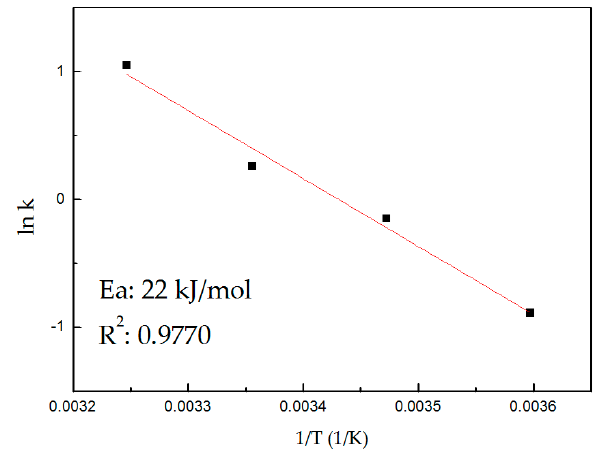
Figure 10. Arrhenius plot for the β -spodumene dissolution in HF medium.